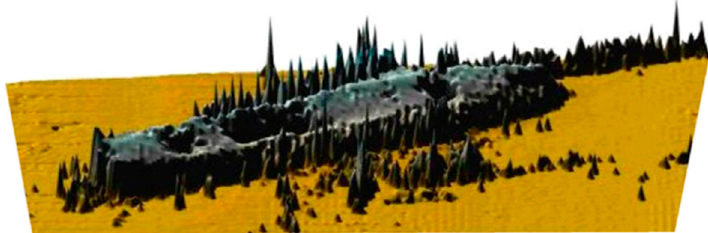
Figure 2. One of the first images of the Graf Zeppelin wreck obtained with the multibeam echo sounder from the deck of St. Barbara.